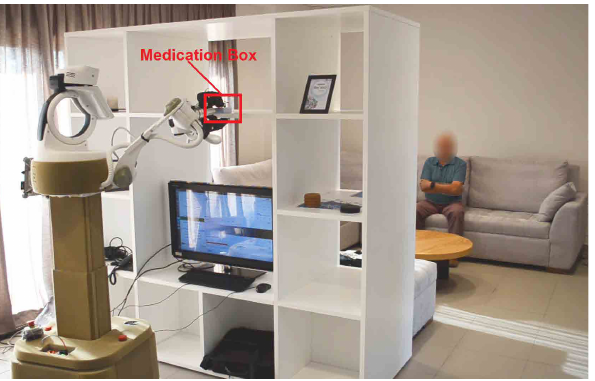
Figure 1. The RAMCIP robot engaged in a real medication adherence assistive task with a user in an actual home